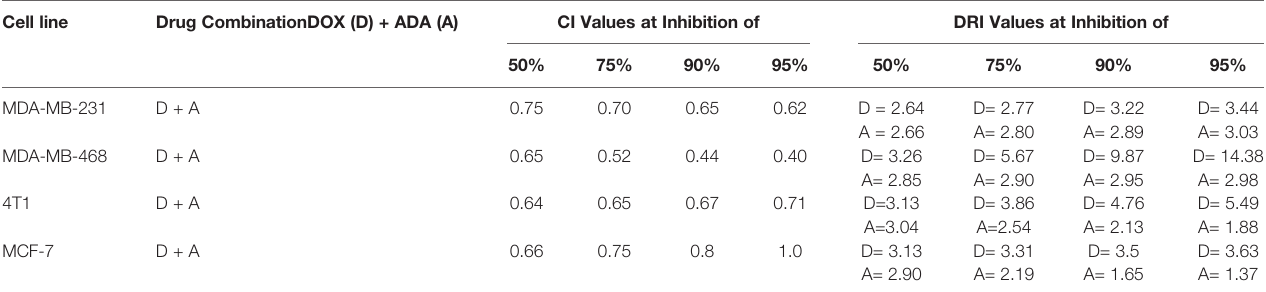
TABLE 2 | Summary of CompuSyn simulated CI and DRI values for Doxorubicin and Adapalene combination in breast cancer cell lines at 50%, 75%, 90%, and 95% growth inhibition. Cell line Drug CombinationDOX (D) + ADA (A) CI Values at Inhibition of DRI Values at Inhibition